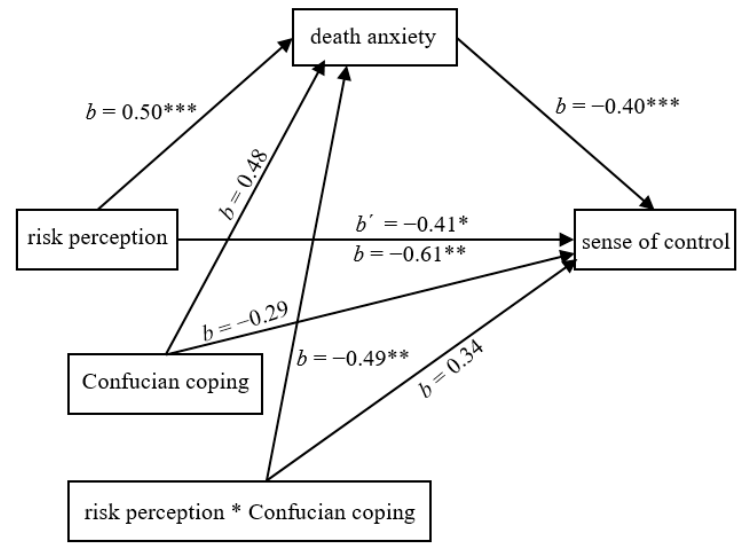
Figure 4. The Moderated Mediation Model in Study 4. * p < 0.05, ** p < 0.01, *** p < 0.001.